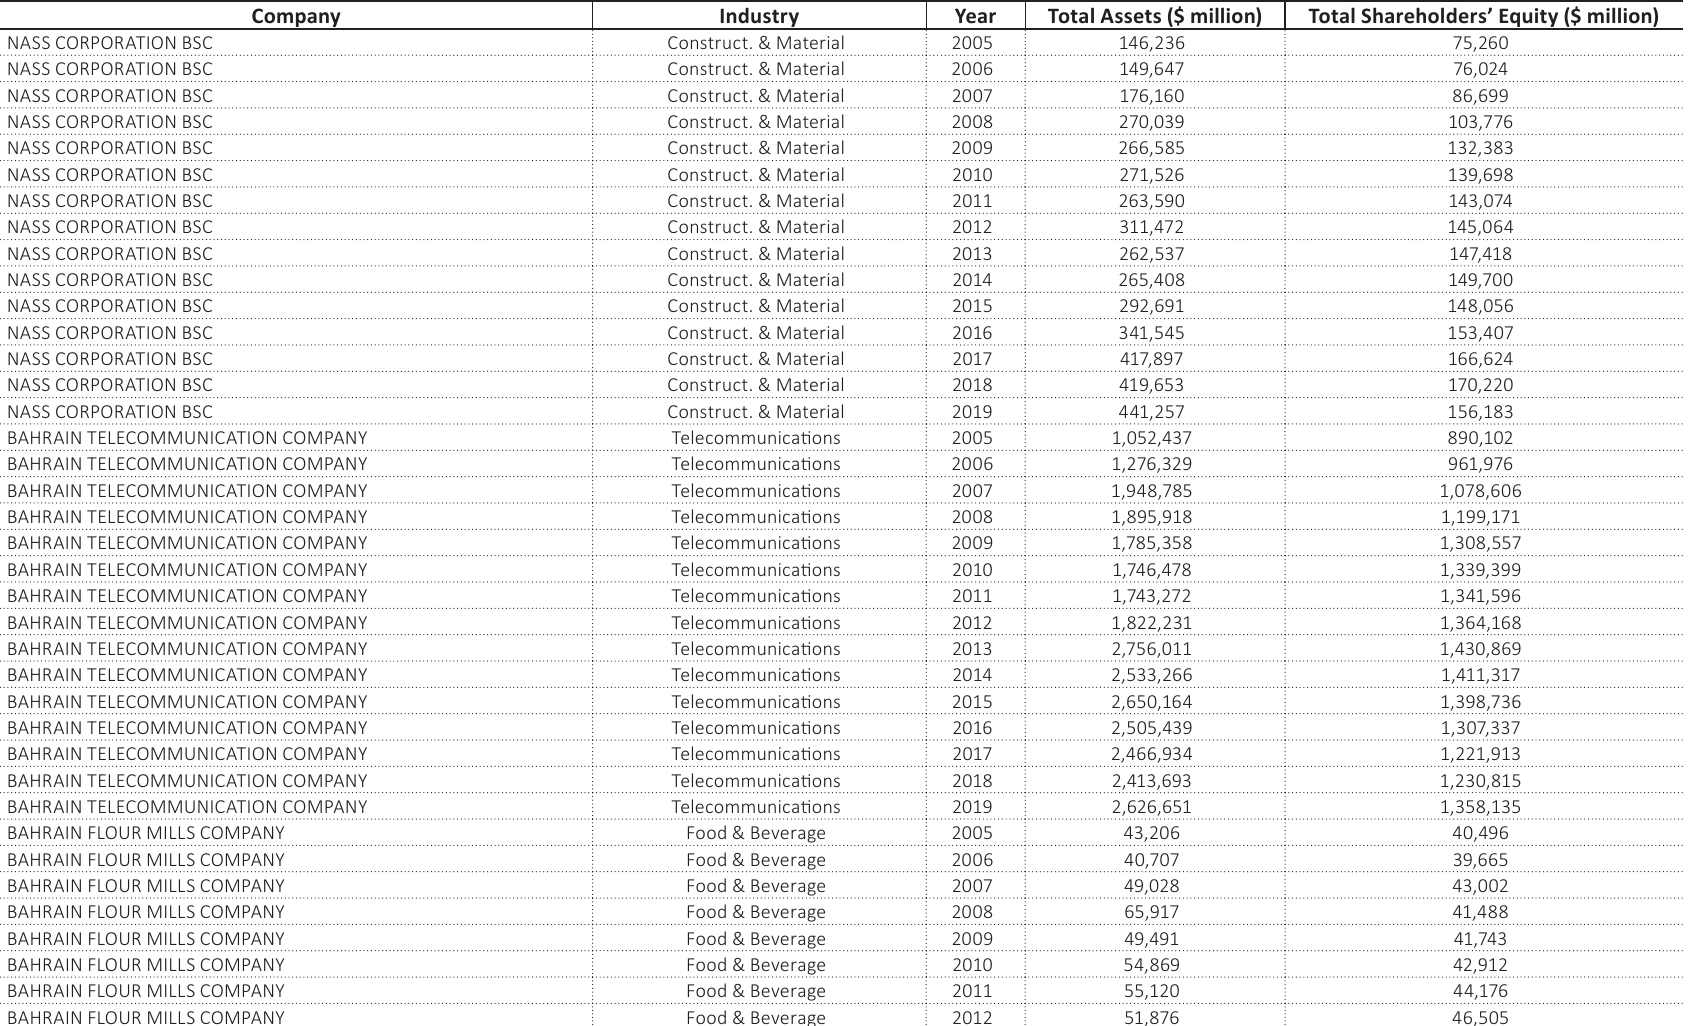
Table A1. List of all Bahraini non-financial listed companies covered by the study